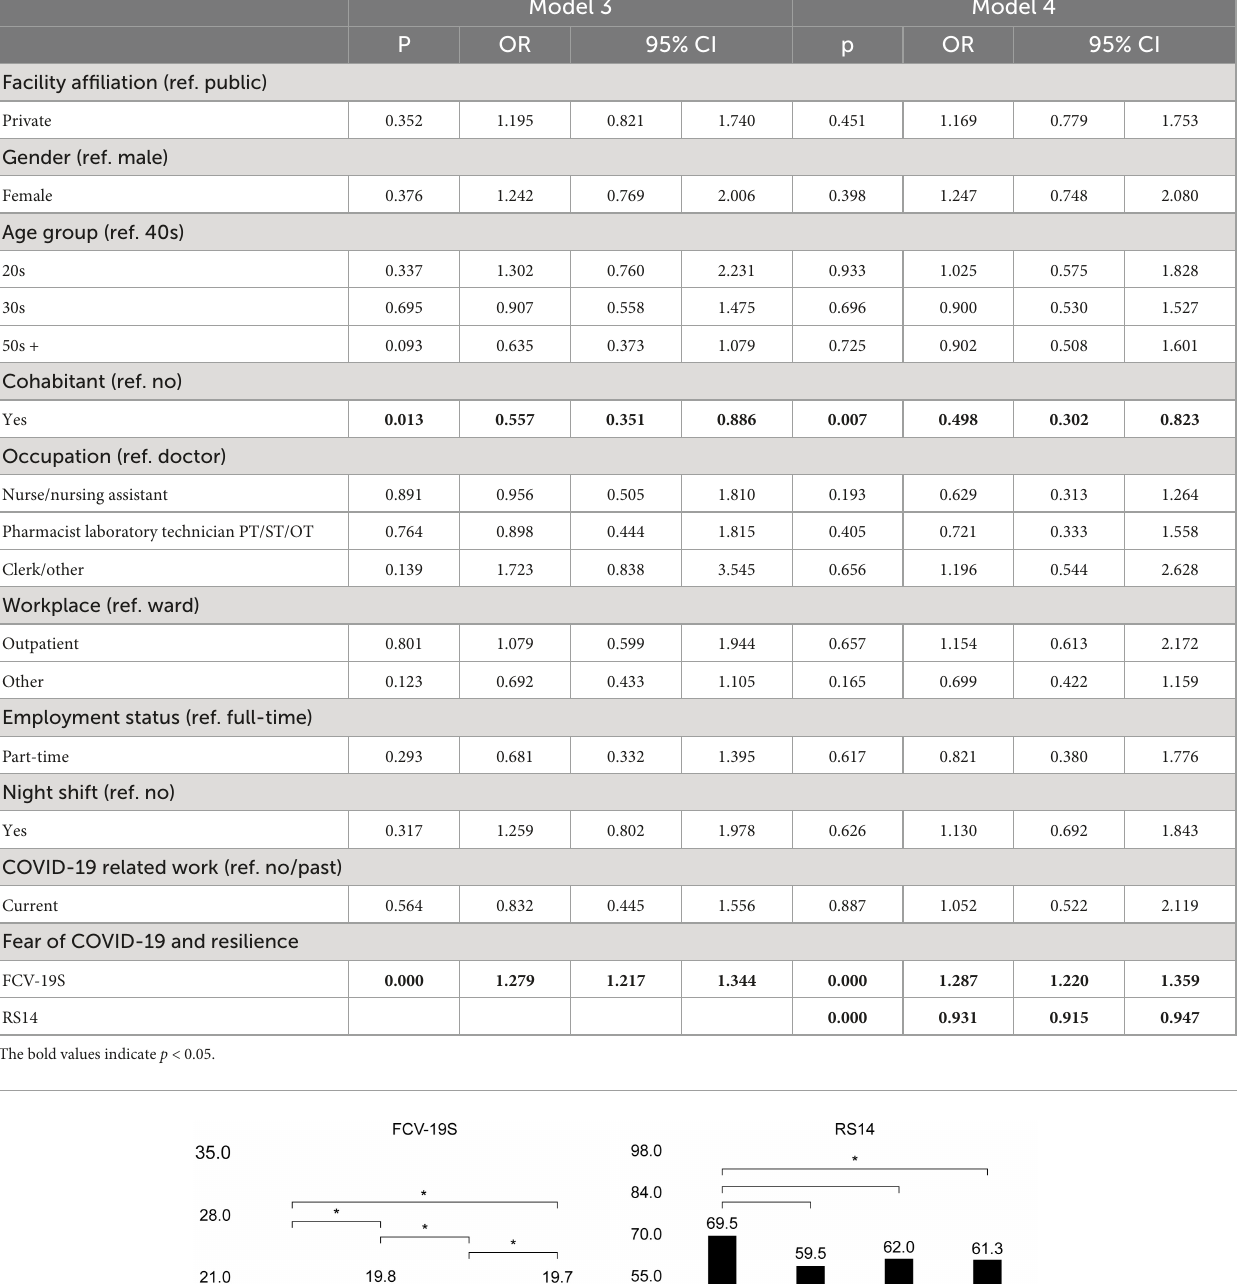
TABLE 3 Logistic regression analysis of psychological distress (Model 3 and Model 4).